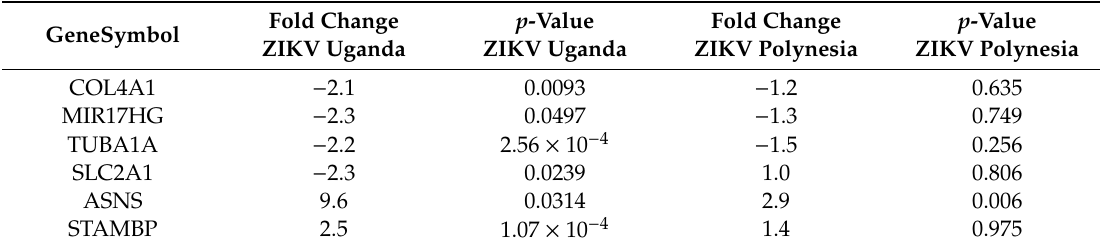
Table 1. Comparative toxicogenomics database screening.